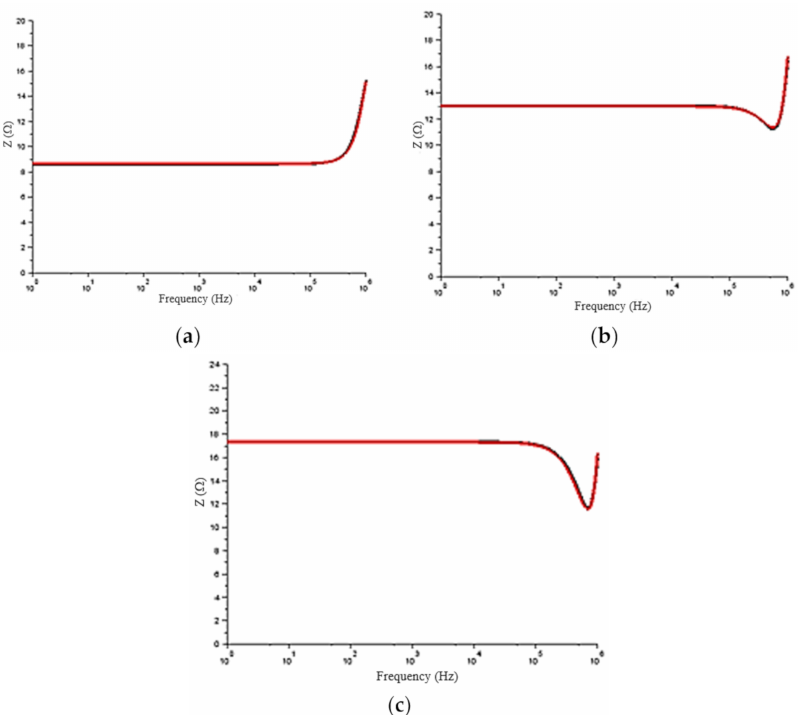
Figure 5. Input impedance of MT4 grounding arrangement in 1 Hz to 1 MHz frequency range. Red line: full circuit model; black line: pi-circuit model. ( a ) ρ g = 300 Ω m; ( b ) ρ g = 450 Ω m; ( c ) ρ g = 600 Ω m.